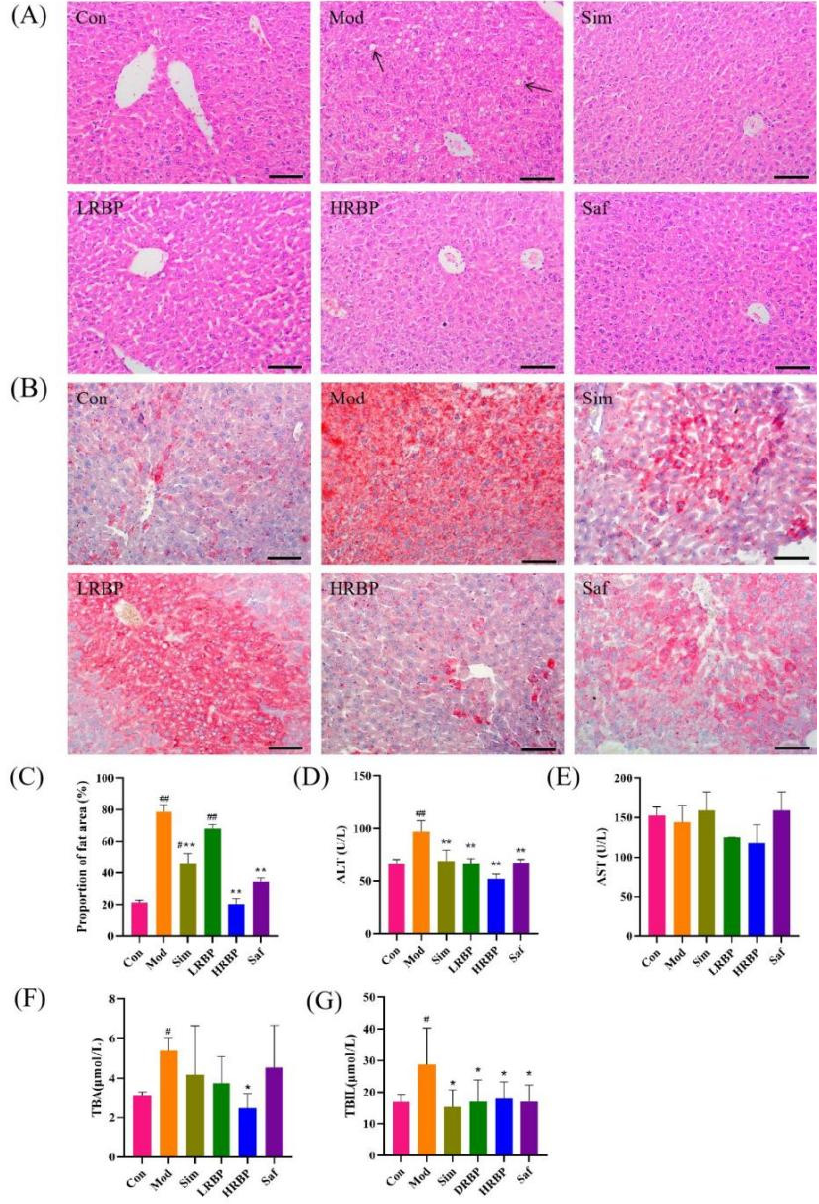
Figure 3. Protective effect of RBPs on the liver in mice. ( A ) The results of HE staining (scale bar = 100 µ m). ( B ) The results of oil red O staining (scale bar = 100 µ m). ( C ) The ratio of red area to the total area in oil red O staining results. The results were measured by Image-Pro Plus 6.0 software. ( D – G ) The content of ALT, AST, TBA, and TBIL in the serum of mice. # p < 0.05, ## p < 0.01 compared to Con group, * p < 0.05, ** p < 0.01 compared to Mod group. Con, control group fed with normal diet; Mod, model group fed with HFD; Sim, positive control group fed with HFD and treated with simvastatin; LRBP, low dose RBPs group fed with HFD and treated with 200 mg/kg RBPs; HRBP, high dose RBPs group fed with HFD and treated with 600 mg/kg RBPs; Saf, safety evaluation group fed with normal diet and treated with 600 mg/kg